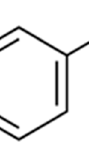
Figure 2. The basic carbon skeleton of phenolics.